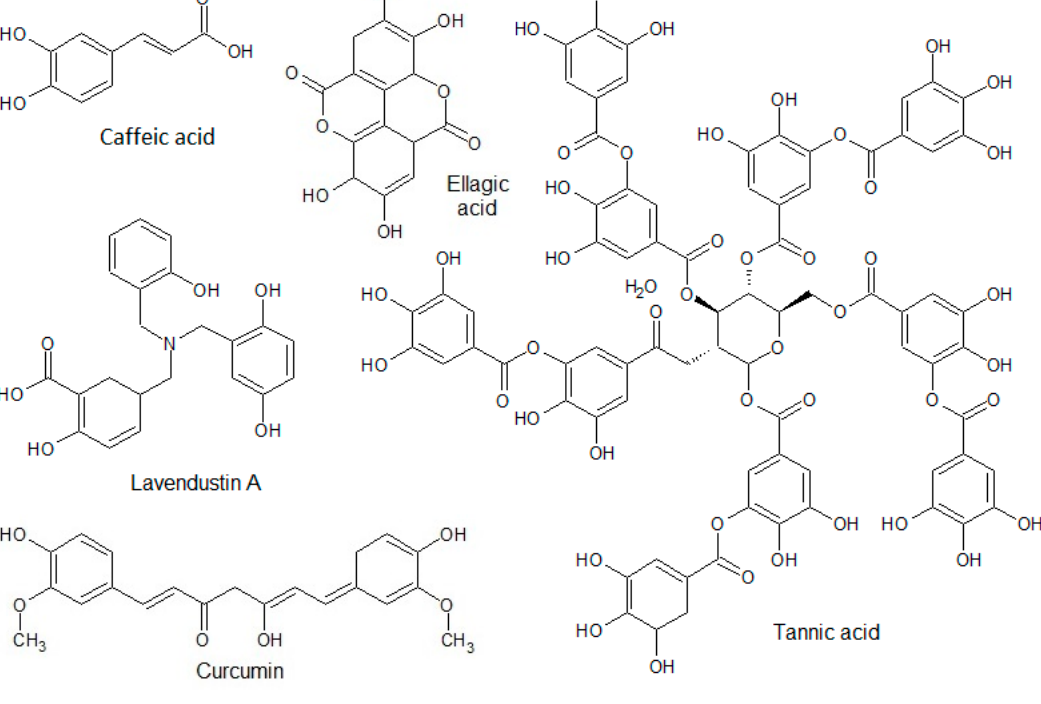
Figure 4. Structures of phenolic acids.